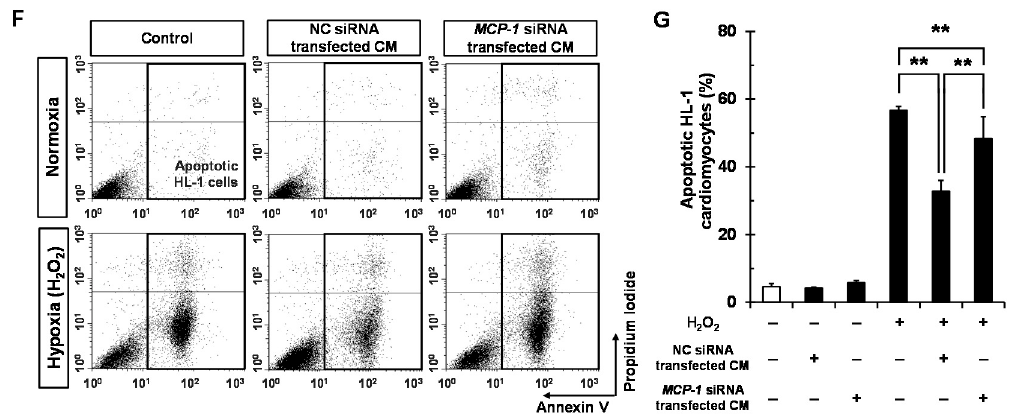
Figure 5. Sca-1+/CD31 − CSCs hTERT CM protects HL-1 cardiomyocytes from hypoxic injury partly via MCP-1-dependent mechanism. Sca-1+/CD31 − CSCs hTERT were cultured in six-well plates at a density of 5 × 10 4 cells/well and transfected with 50 nM of MCP-1 siRNA duplexes or NC siRNA duplexes using Lipofectamine RNAiMAX. After a 48 h transfection, MCP-1 mRNA expression was assessed by real-time PCR ( A ); The average value of MCP-1 mRNA was normalized to that of GAPDH for each sample. The data represent the mean ± SD from three experiments. Sca-1+/CD31 − CSCs hTERT CM ( B ) after transfection of NC siRNA or MCP-1 siRNA were subjected to densitometry and are presented as fold changes for MCP-1 (indicated by number 6) and IL-6 (indicated by number 15) ( C ), taking MCP-1 and IL-6 levels in NC siRNA-transfected Sca-1+/CD31 − CSCs hTERT as a one-fold value, each in triplicate, * p < 0.05; ** p < 0.01 vs. NC siRNA; ( D ) representative flow cytometric analysis showing apoptotic effects on HL-1 cardiomyocytes treated with or without 150 µM CoCl 2 for 24 h in the absence or presence of Sca-1+/CD31 − CSCs hTERT CM transfected with NC siRNA or MCP-1 siRNA. Bar graph of three independent experiments showing percentages of apoptotic HL-1 cardiomyocytes ( E ) treated with or without 150 µM CoCl 2 for 24 h in the absence or presence of Sca-1+/CD31 − CSCs hTERT CM transfected with NC siRNA or MCP-1 siRNA (** p < 0.01); and ( F ) representative flow cytometric analysis showing apoptotic effects on HL-1 cardiomyocytes treated with or without 200 µM H 2 O 2 for 24 h in the absence or presence of Sca-1+/CD31 − CSCs hTERT CM transfected with NC siRNA or MCP-1 siRNA; Bar graph of three independent experiments showing percentages of apoptotic HL-1 cardiomyocytes ( G ) treated with or without 200 µM H 2 O 2 for 24 h in the absence or presence of Sca-1+/CD31 − CSCs hTERT CM transfected with NC siRNA or MCP-1 siRNA (** p < 0.01).